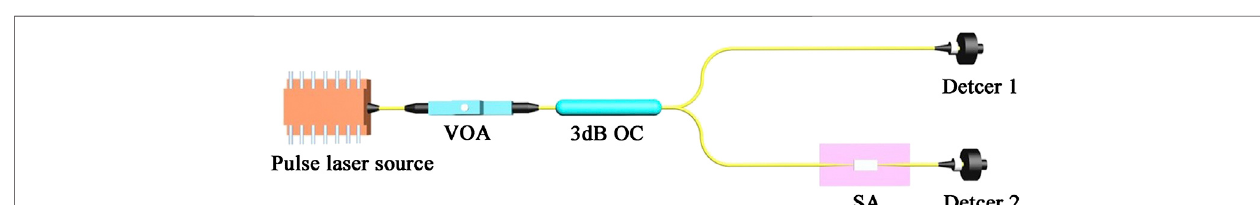
Frontiers in Physics |